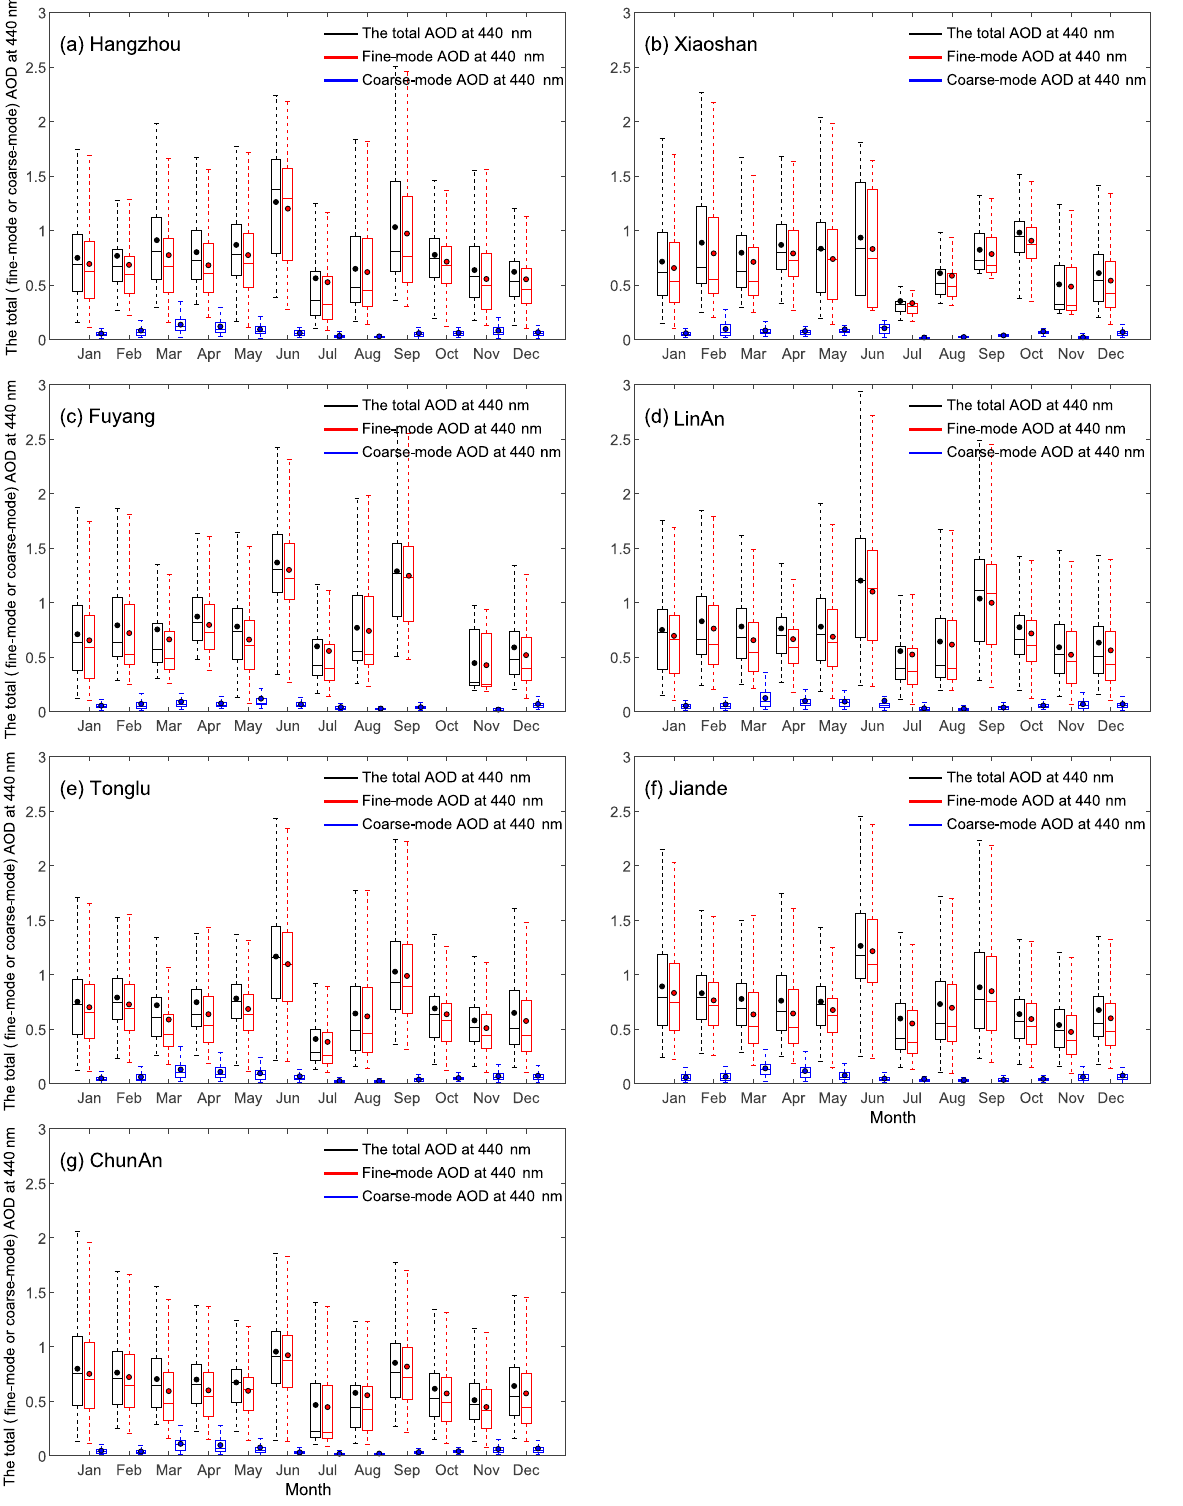
Figure 3. Variations in the total, fine-mode and coarse-mode AOD 440nm at (a) Hangzhou, (b) Xiaoshan, (c) Fuyang, (d) LinAn, (e) Tonglu, (f) Jiande and (g) ChunAn. The boxes represent the 25th to 75th percentiles of the distributions while the dots and solid lines within each box represent the means and medians,